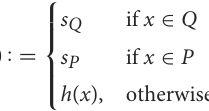
FIGURE8 (A) Two point-sized independent bodies move along continuous paths in an annulus-shaped region in the plane. There are three sensor beams, a , b , and c . When each is crossed by a body, its corresponding symbol is observed. Based on receiving a string of observations, the task is to determine whether the two bodies are together in the same region, with no beam separating them. (B) The minimal filter as a transition system has only 4 states: T means that they are together, and D x means that are in different regions but beam x separates them. Each transition is triggered by the observation when a body crosses a beam.